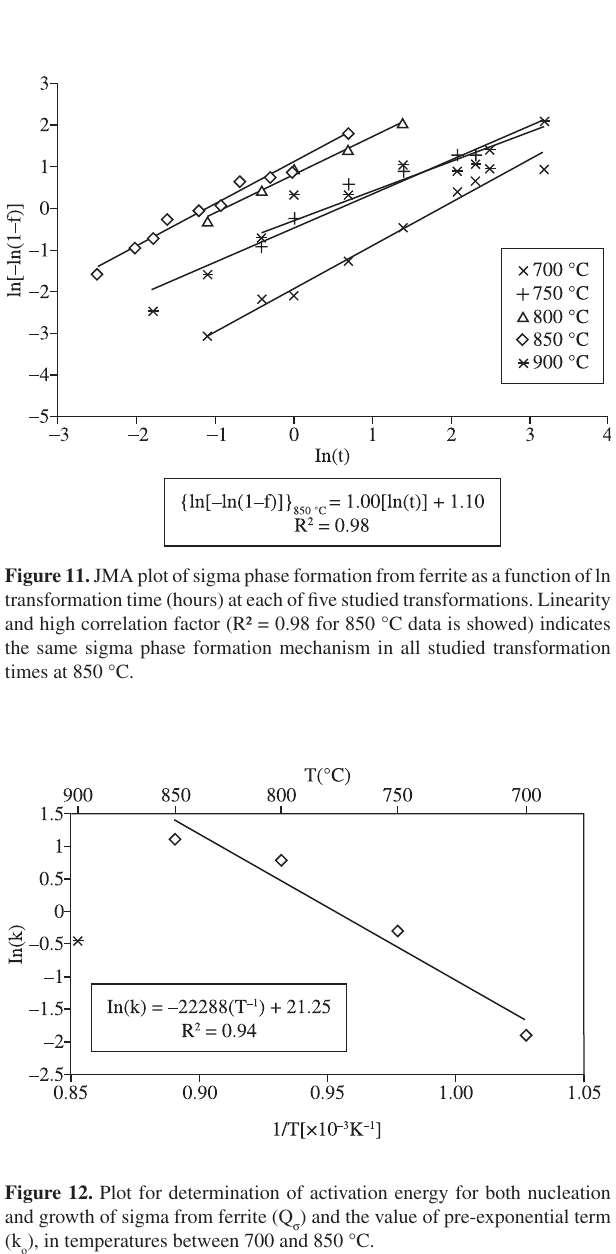
) and the value of pre-exponential term σ